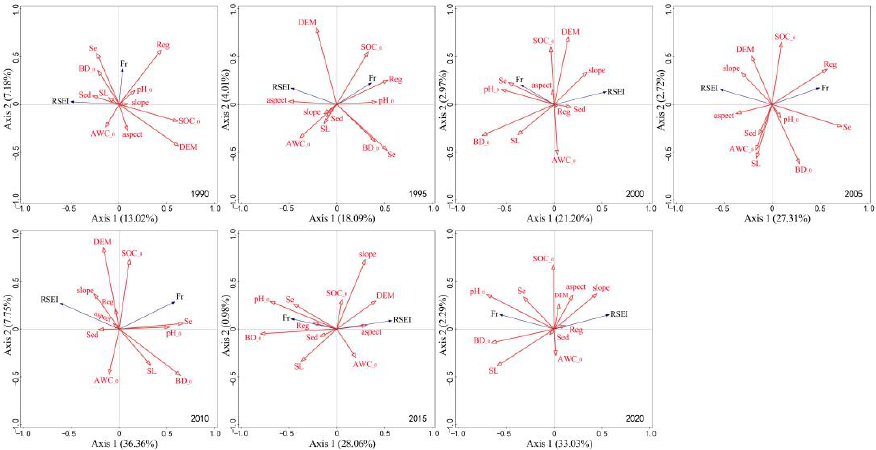
Figure 8. Correlation of RSEI and Fr with soil and topographic factors. Note: RSEI, Fr, dem, slope, aspect, pH _0 , BD _0, AWC _0 , SOC _0 , Se, Reg, SL, and Sed respectively represent remote sensing-based ecological index, rock outcrop rate, elevation, slope gradient, slope aspect, soil pH value, soil bulk density, soil available water content, soil organic carbon in soil surface, soil erosion, regolith thickness, soil layer thickness, and sedimentary layer thickness; RSEI and Fr are response variables and the rest are interpretation variables.